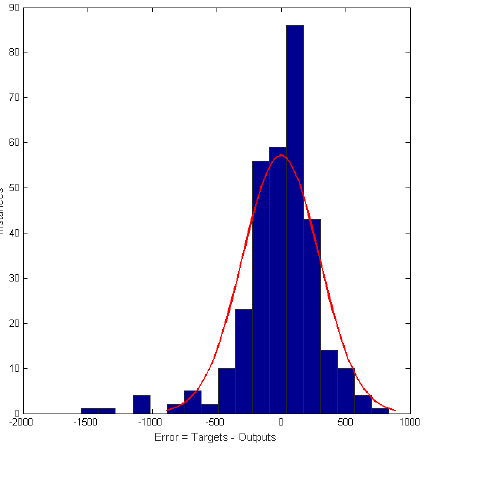
Figure 6. Training error for forecast hourly load of working days of household No 71.